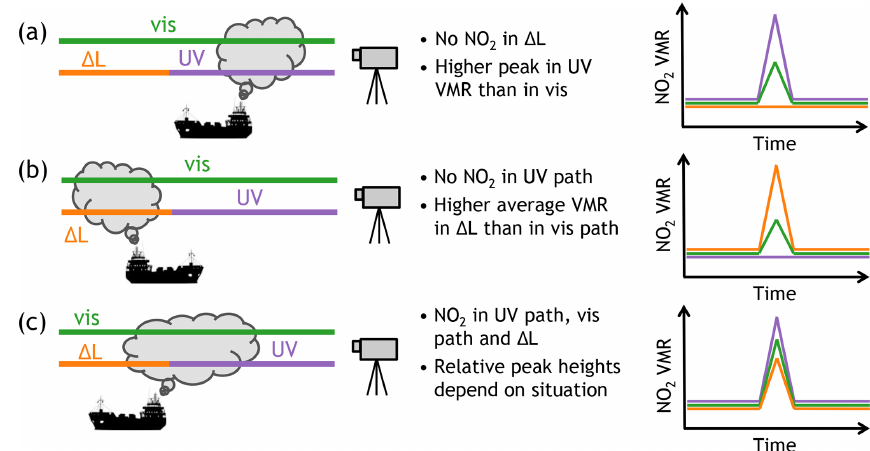
Figure 2. Plume–light path geometry and the resulting path-averaged NO 2 concentrations for three possible cases: when the plume is close to the instrument and completely covered by the UV path (a) , when the plume is further away from the instrument than the UV scattering point and is only covered by the visible path (and (cid:49)L ) (b) , and when the plume is located around the UV scattering point (c) .